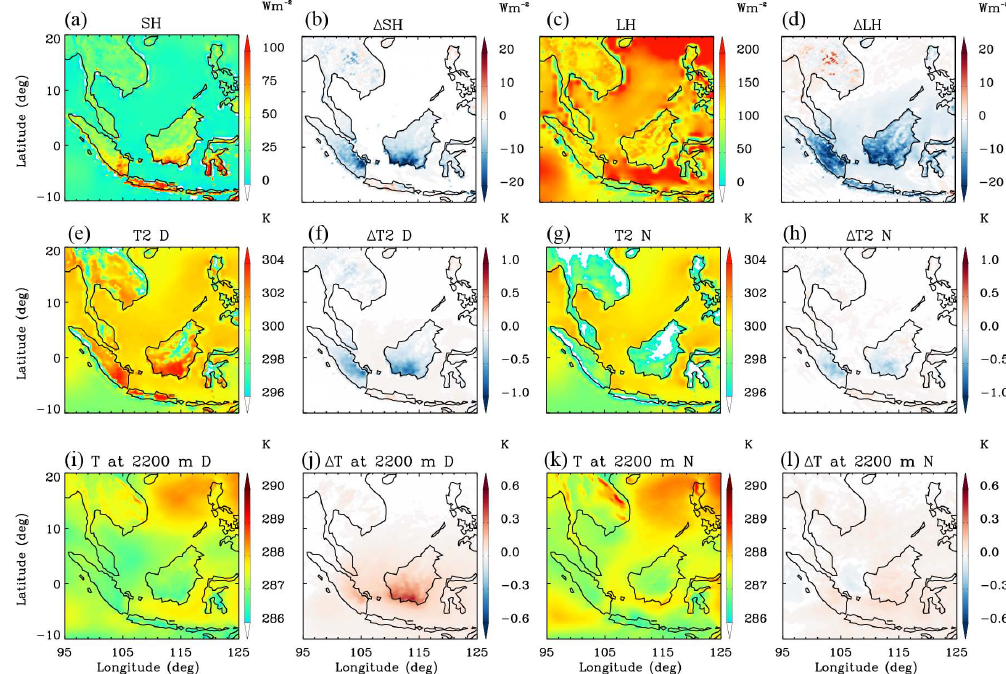
Fig. 2. Distribution of monthly averaged variables in October 2006. (a) Sensible heat flux at the surface (SH) without consideration of smoke radiative interaction, (b) difference of SH ( 1 SH) due to the smoke radiative interaction. (c–l) are all paired similarly to the pair of (a) and (b) but for latent heat (LH), 2m air temperature ( T 2) at daytime, T 2 at night, temperature at 2.2km above terrain at daytime, and temperature at 2.2km above terrain at nighttime, respectively. The difference of each variable ( 1V ) is defined as 1V = V Ra − V non-Ra . D donates daytime, i.e., the time period between 08:00LT and 19:00LT, and N donates nighttime, i.e., between 20:00LT and 07:00LT. The OC/BC ratio is